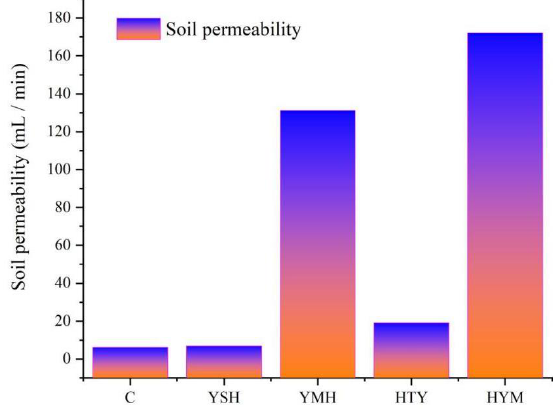
Figure 4. Soil permeability of different agroforestry.